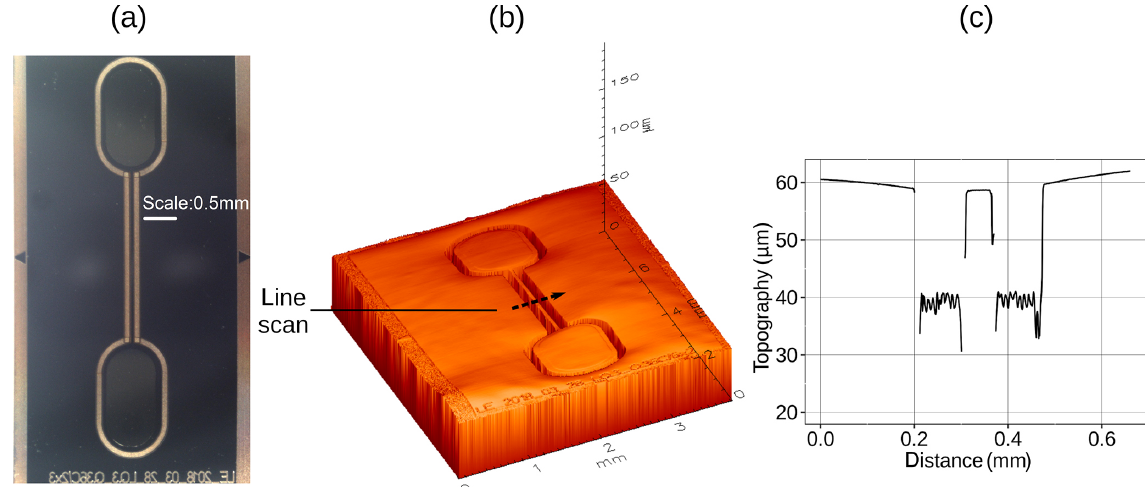
Figure 4. (a) Microscopic image of an SG produced with bone structure. (b) Topography of a strain gauge with bone structure measured by means of a chromatic white-light sensor. (c) The height of the path that is recognizable in the line scan is around 20µm.